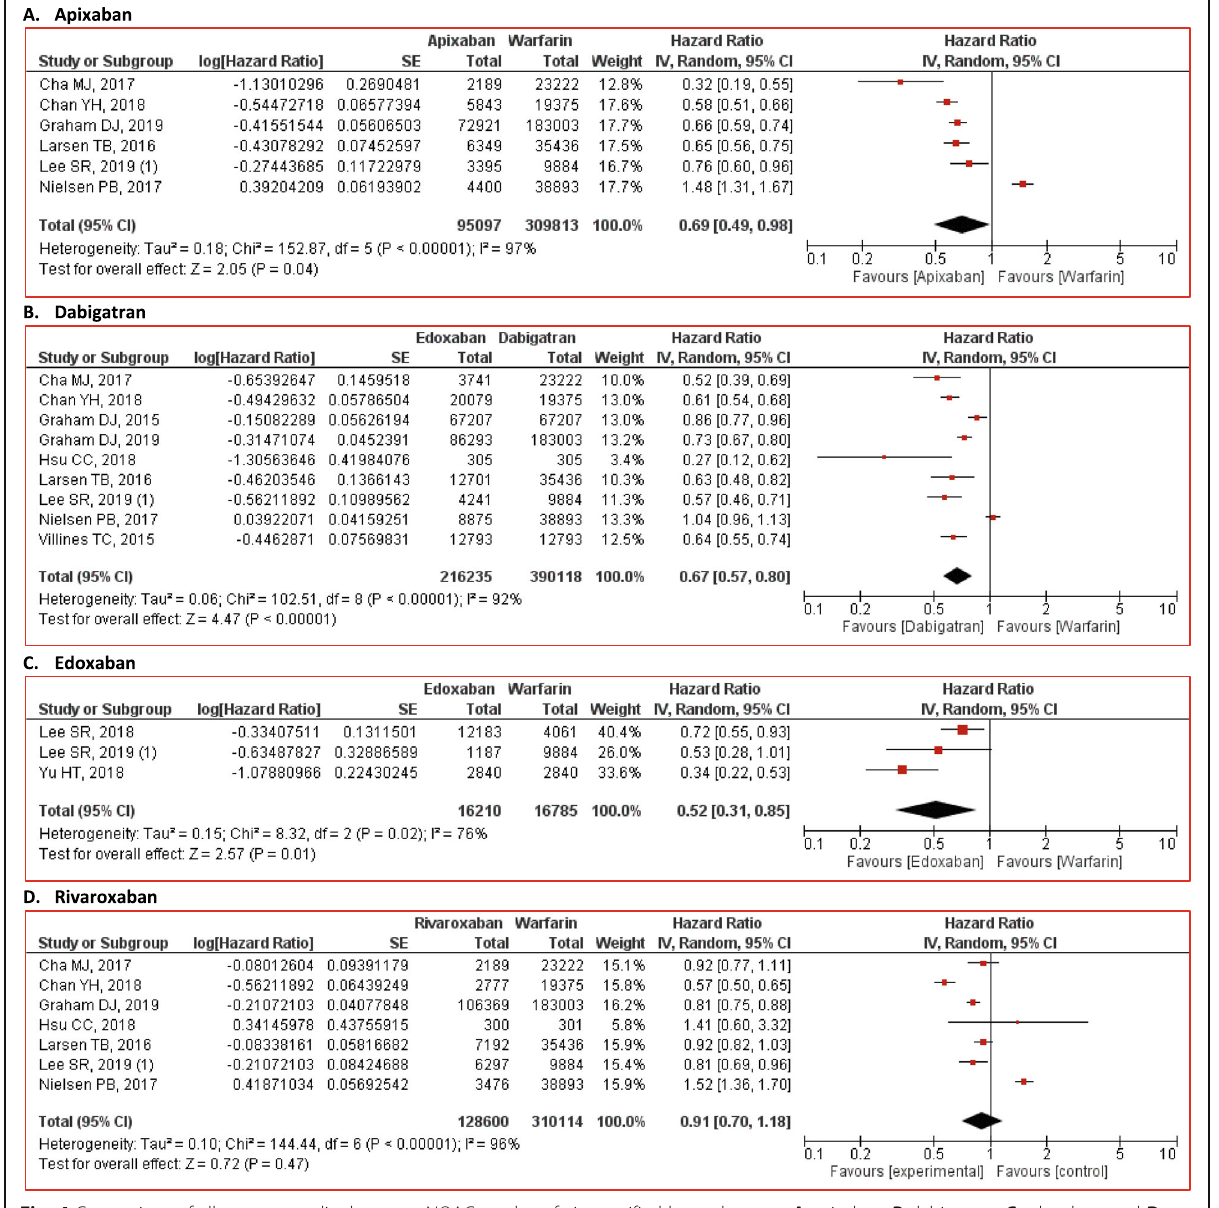
Fig. 4 Comparison of all-cause mortality between NOACs and warfarin stratified by each agent. A apixaban, B dabigatran, C edoxaban, and D rivaroxaban. CI = confidence interval, NOACs = non-vitamin K antagonist oral